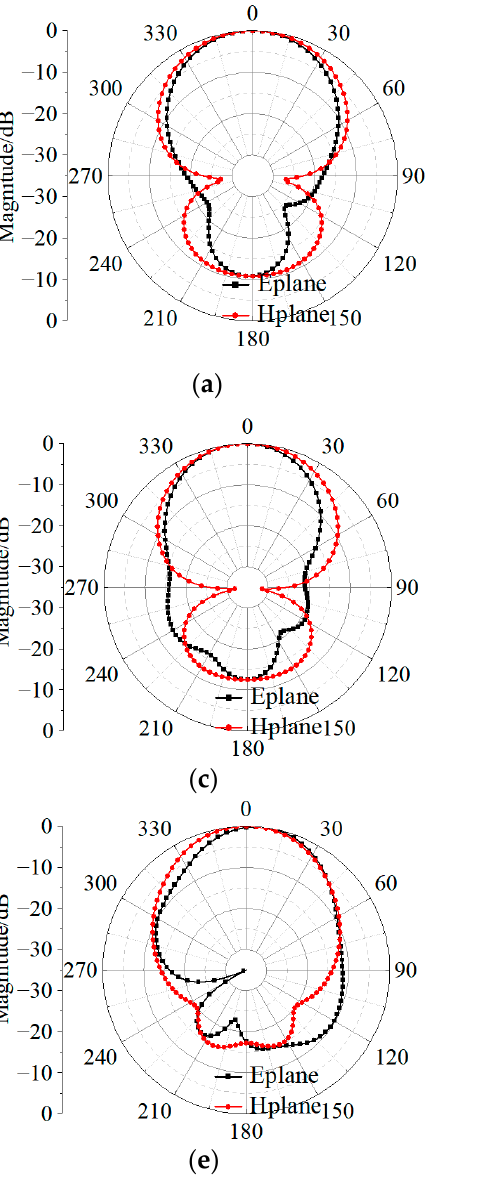
Figure 8. Current distribution on the antenna element at ( a ) 13 GHz, ( b ) 16 GHz, ( c ) 17.5 GHz, and ( d ) 18 GHz.